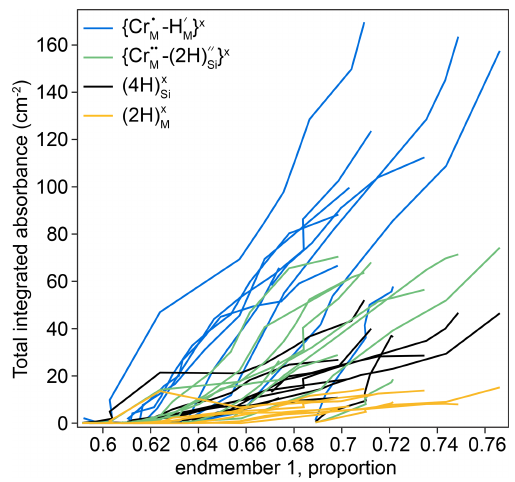
Figure 11. The defect-specific integrated total FTIR absorbance versus the proportion of component 1 in the XANES spectra. The lower left represents the crystal cores (low absorbance, low end-member 1), and the upper right represents the rims (high ab- sorbance, high end-member 1). All curves are broadly linear. Rel- ative uncertainties in linear combination fitting are mostly 0.2%– 1.5%; these are presented in the Supplement. An expanded version of the same figure separated into individual experiments is given in Fig. S11.